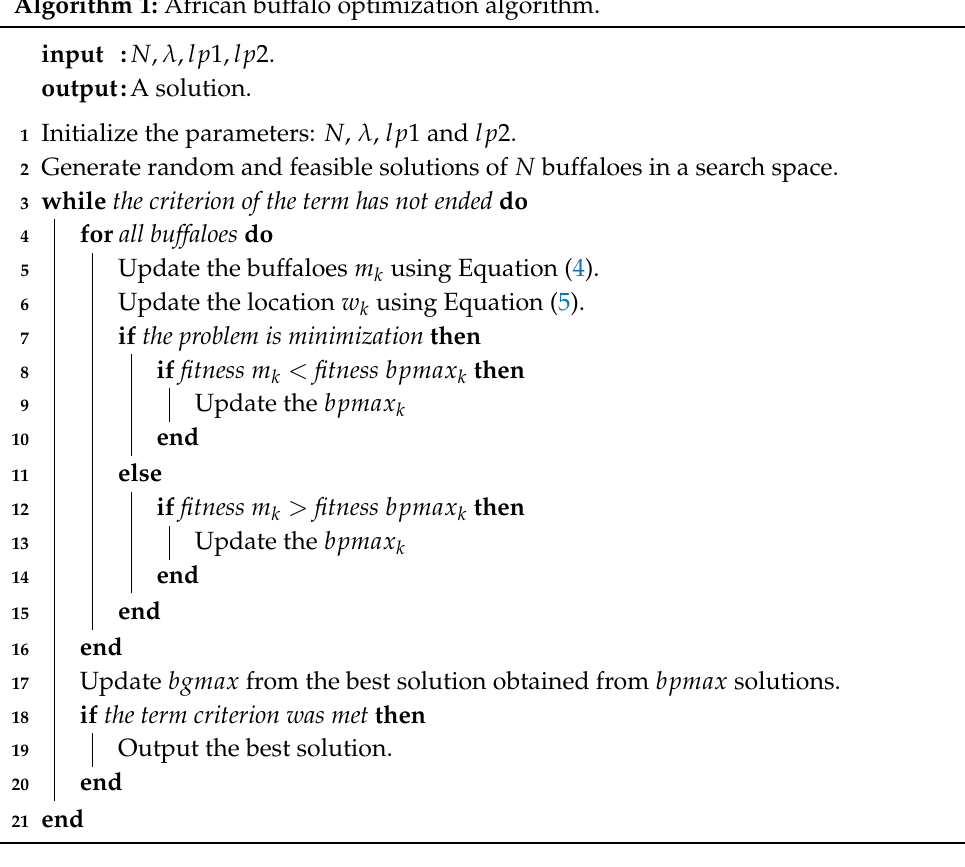
African Buffalo Optimization Algorithm